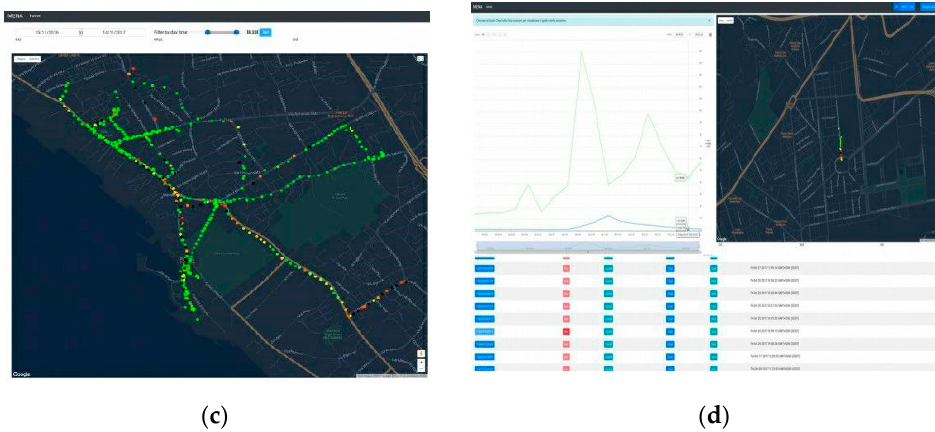
Figure 1. MONICA system. ( a ) Three different linear univariate calibration curves for MONICA CO sensor, computed from the in lab recorded data. It is possible to note the influence of Temperature on CO sensor response; ( b ) The Monica v2.0 prototype and a snapshot of the MONICA Android app showing, in color coding, a personal pollutant exposure index, computed using the recorded CO, NO 2 , O 3 concentrations; ( c ) A point cloud map visualization of test campaign recorded NO 2 concentrations (color coded) in the MENA web panel; ( d ) MENA web panel interface (Premium funders, below).